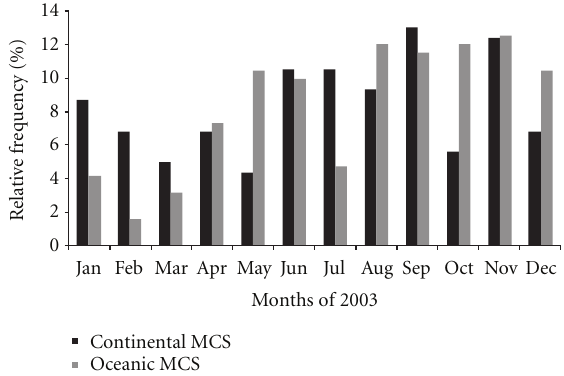
Figure 3: Relative frequency of continental and oceanic convective systems observed during